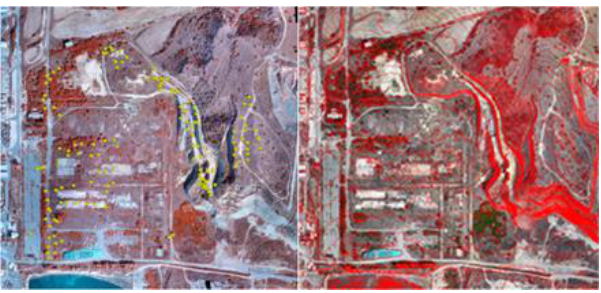
Figure 10: NIR orthophoto of test site B, with 0.25 m pixel size and the 137 reference points (left) overlaid and RGB orthophoto with 1m contours (right)